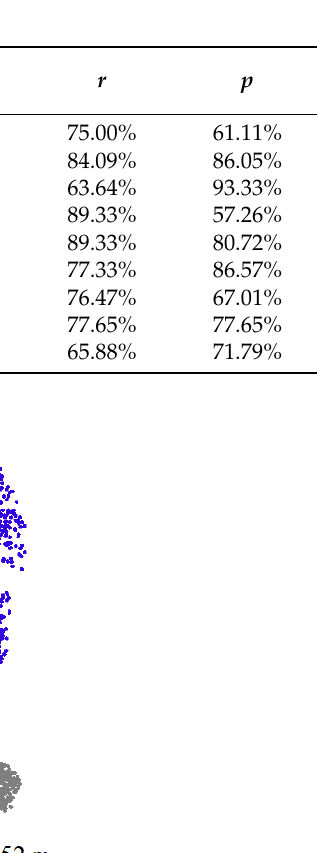
Table 3. Sensitivity analysis of PCS.